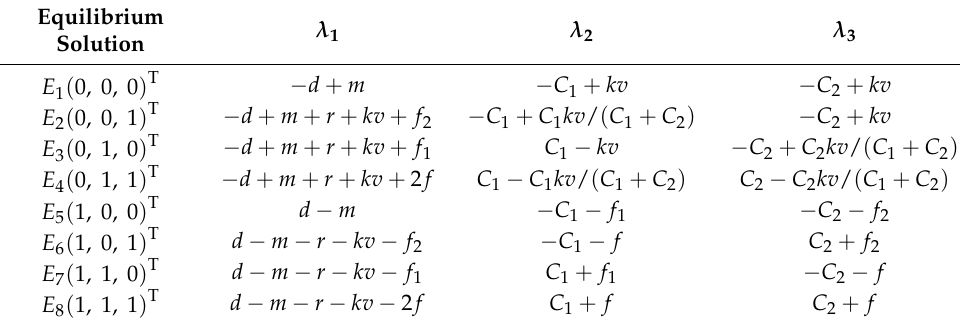
Table 4. The eigenvalues of the Jacobi